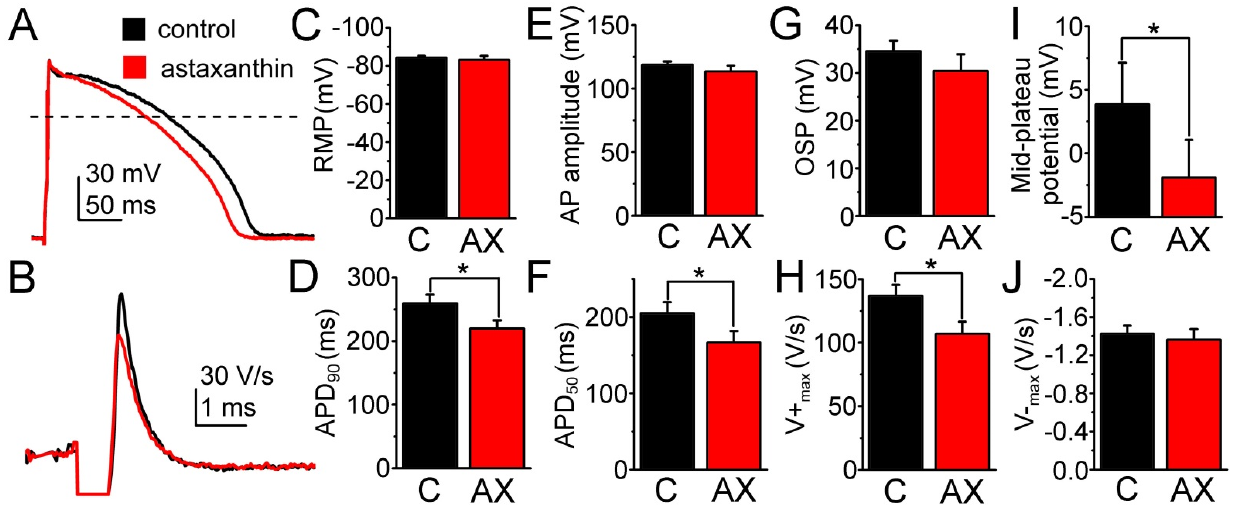
Figure 6. Effects of astaxanthin on the parameters of action potentials in canine left ventricular myocytes. ( A ) Representative superimposed action potentials recorded in control (black) and in the presence of 2.5 µM astaxanthin (red). ( B ) First time derivative of the action potential upstroke with the same color code. ( C – J ) Average results obtained from 7 cells in control and in the presence of astaxanthin (black, C: control; red, AX: astaxanthin; columns and bars: mean ± SEM; asterisks: significant differences are noted by * with p < 0.05).